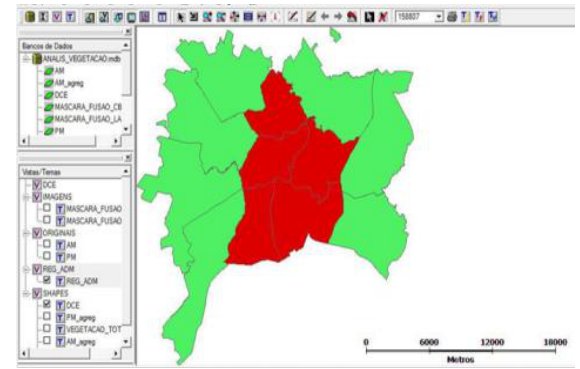
Figure 4 – Mask Generation (in red).